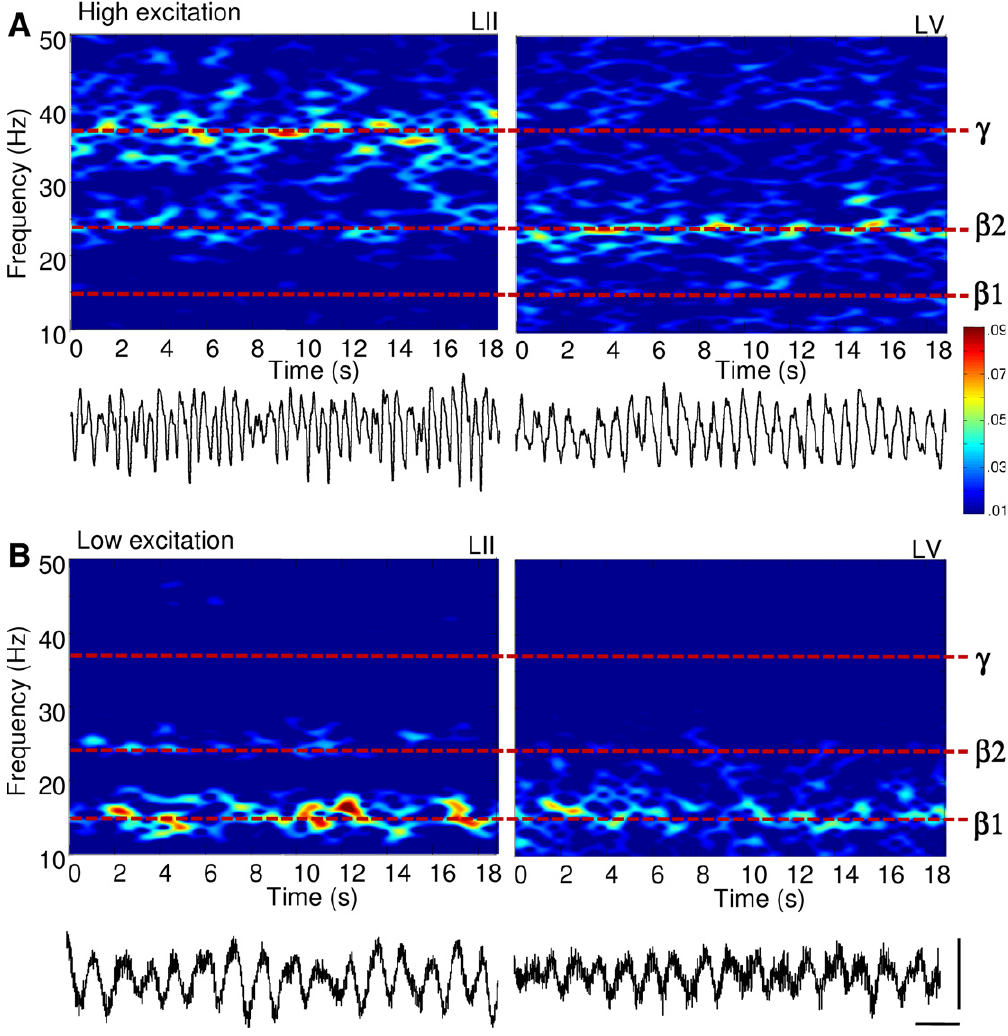
Figure 1. Reduction in excitatory drive to neocortex transforms concurrent gamma (35–45 Hz) and beta2 (22–28 Hz) oscillations into a beta1 (13–18 Hz) rhythm. Spectrograms of local fi eld potential data from LII and LV in rat cortex in vitro. (A) Laminar separation of gamma (LII) and beta2 (LV) frequency population rhythms in the presence of 400 nM kainate. Example traces (1 s epoch) of superfi cial (layer II), and deep (layer V) recordings showing the nature of the two rhythms are shown below. (B) Acute reduction in glutamatergic excitation in neocortex with 2.5 μ M NBQX, following 2 h of stable gamma/beta2 oscillations abolished both fi eld potential rhythms, generating persistent beta1 frequency rhythms in both laminae. Example traces (1 s epochs) of fi eld potential beta1 frequency rhythms in layer II and layer V are shown below. Scale bars 100 ms, 50 μ